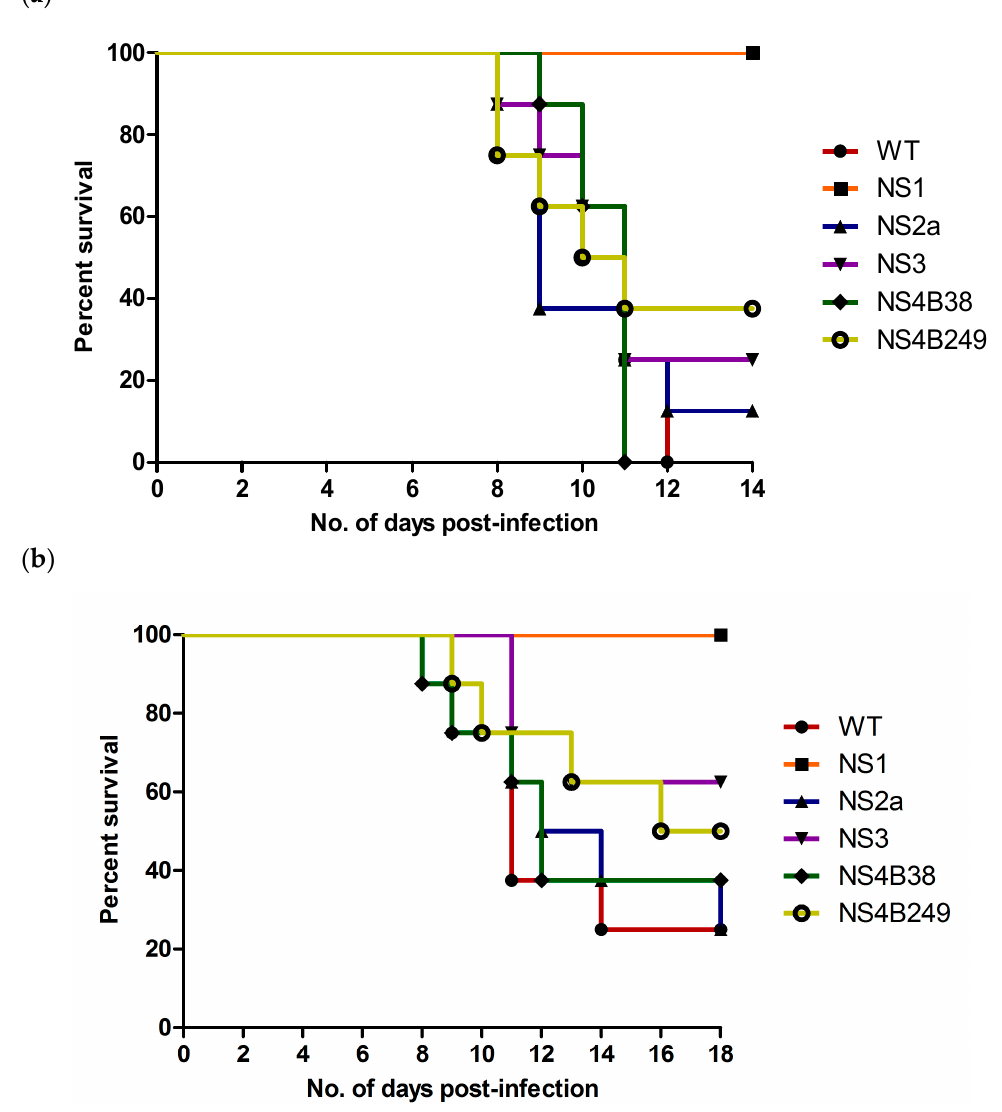
Figure 4. Survival of six-week-old female C57/Bl6 mice after i.p. inoculation, with ( a ) high dose (10 4 TCID 50 ) and ( b ) low dose (10 1 TCID 50 ) of recombinant WNVs.